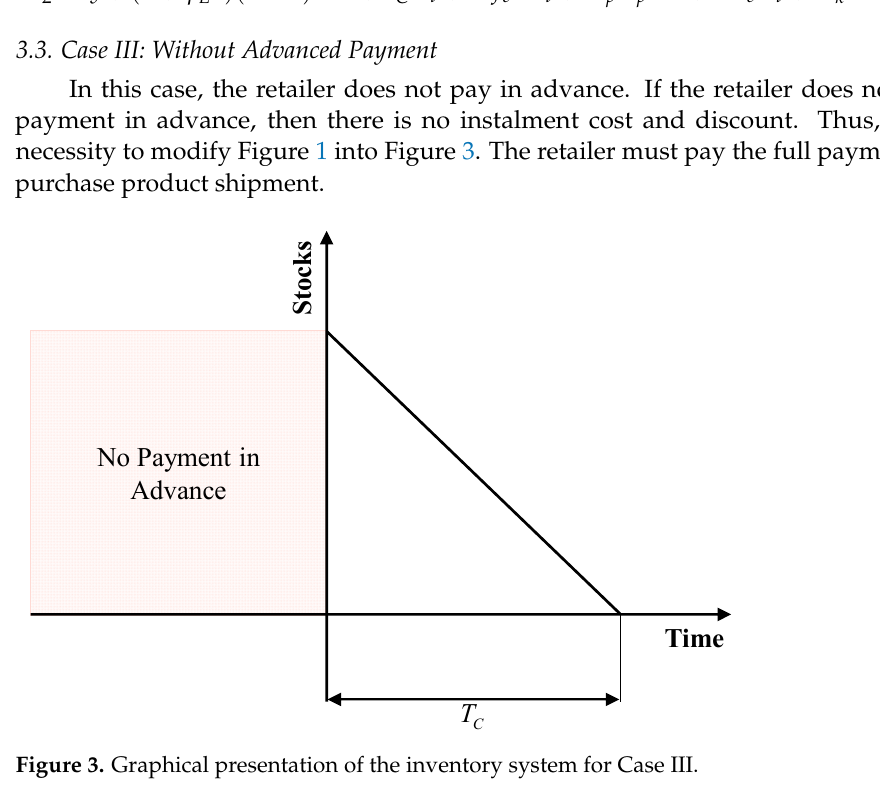
Figure 3. Graphical presentation of the inventory system for Case III.